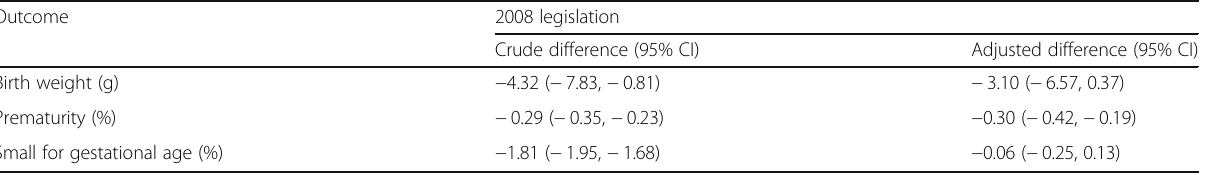
Table 2 Estimated effect adjusted of anti-smoking legislation on birth outcomes in Peru Outcome 2008